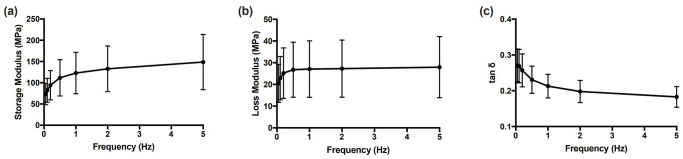
Storage (E’) modulus (a), loss (E”) modulus (b) and tanδ (c) against frequency for all samples.Error bars denote standard deviations.